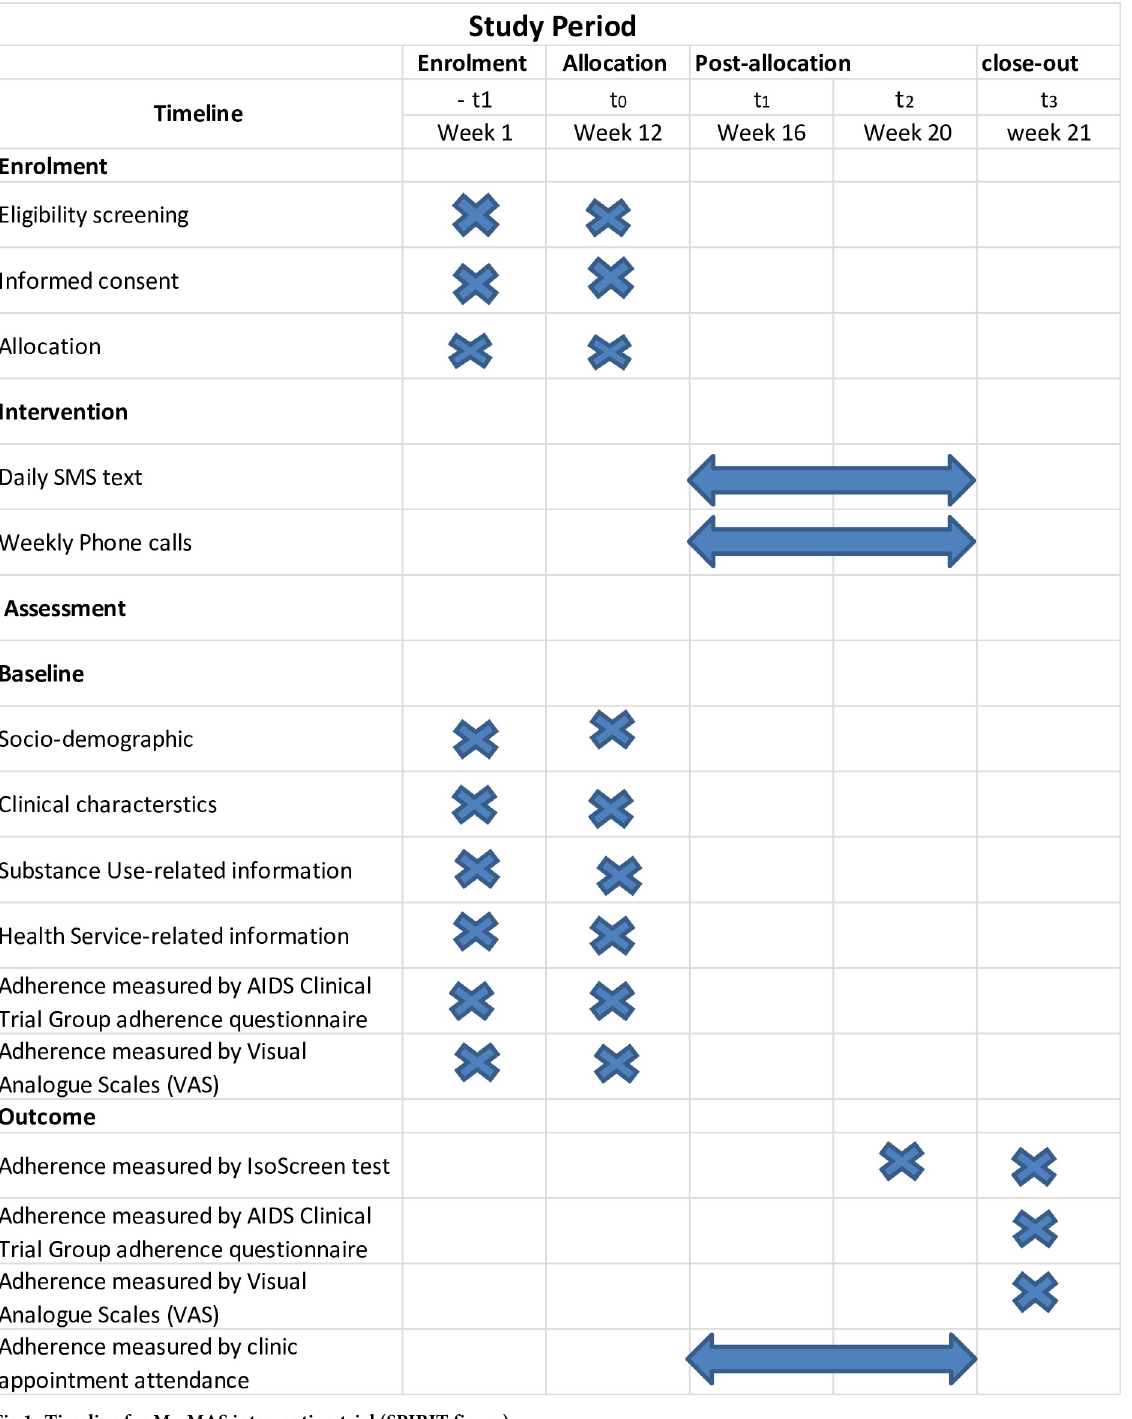
Fig 1. Timeline for Ma-MAS intervention trial (SPIRIT